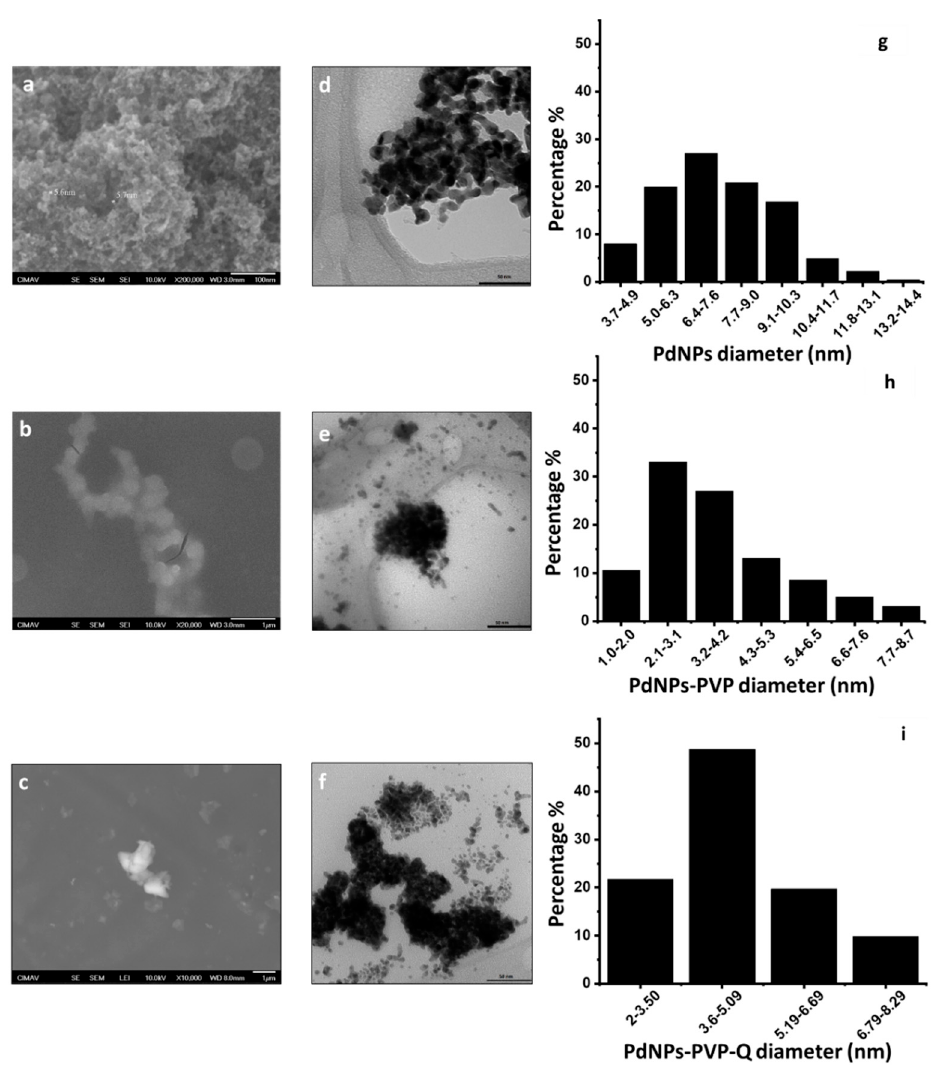
Figure 2. Characterization of size and morphology by electron microscopy. ( a – c ) Scanning electron microscopy: ( a ). PdNPs alone, ( b ). PdNP-PVP, and ( c ). PdNP-PVP-Q. ( d – f ) Transmission electron microscopy: ( d ). PdNPs alone, ( e ). PdNP-PVP, and ( f ). PdNP-PVP-Q. ( g – i ). Distribution analysis of primary size: ( g ). PdNPs alone, ( h ). PdNP-PVP, and ( i ). PdNP-PVP-Q. The white and black lines represent the scale in every micrograph in a ‐ f.